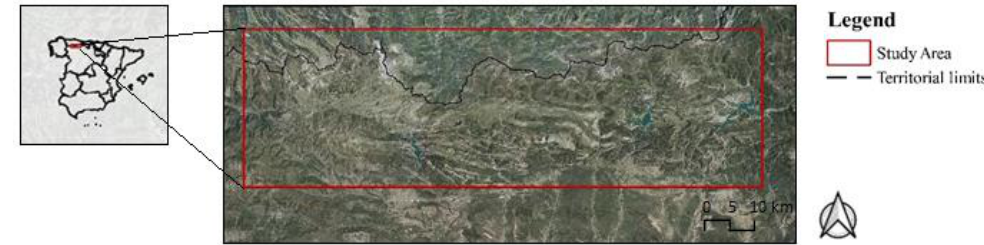
Figure 1. Location of the study area in the Cantabrian Mountains, northwest of the Iberian Peninsula (the top-left panel shows the regional boundaries of Spain).